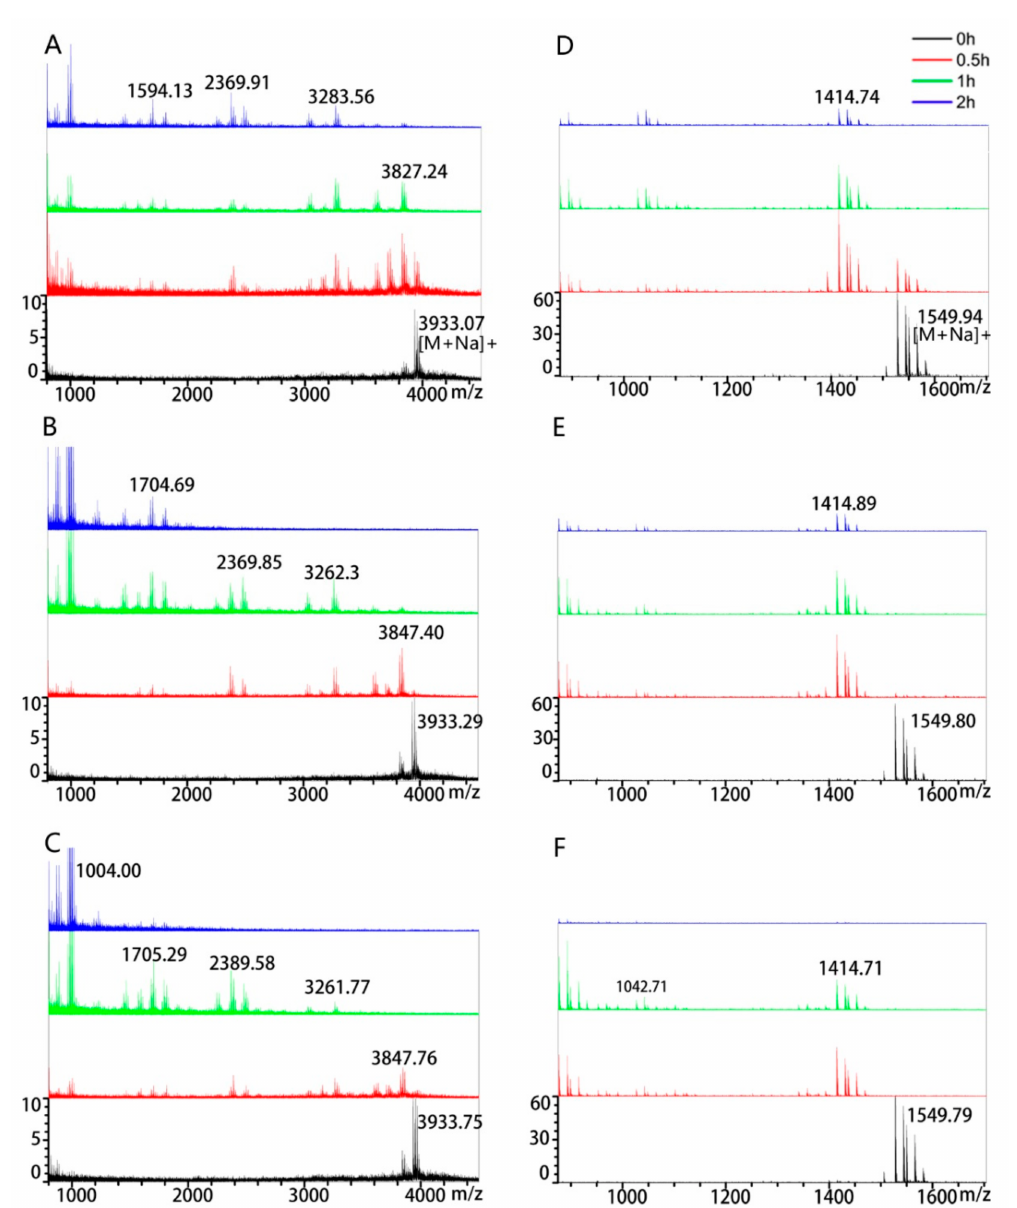
Figure 3. MALDI–TOF analysis of the degradation profiles of the immunotoxic peptides. The cell densities used for the incubations were OD 620 1.2. The initial concentration of 33-mer gliadin peptide and 13-mer gliadin peptide was 0.5 mg/mL and 0.25 mg/mL. The 13-mer gliadin peptide was incubated with B. cereus CH ( A ), B. cereus 21155 ( B ) and B. cereus AFA01 ( C ) for 0, 0.5, 1 and 2 h, respectively. The 13-mer gliadin peptide was incubated with B. cereus CH ( D ), B. cereus 21155 ( E ) and B. cereus AFA01 ( F ) for 0, 0.5, 1 and 2 h,